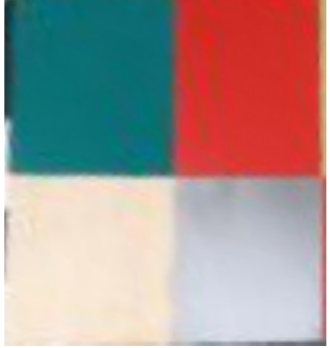
Figure 7. The segment no 3: Various materials (image obtained with RGB camera)